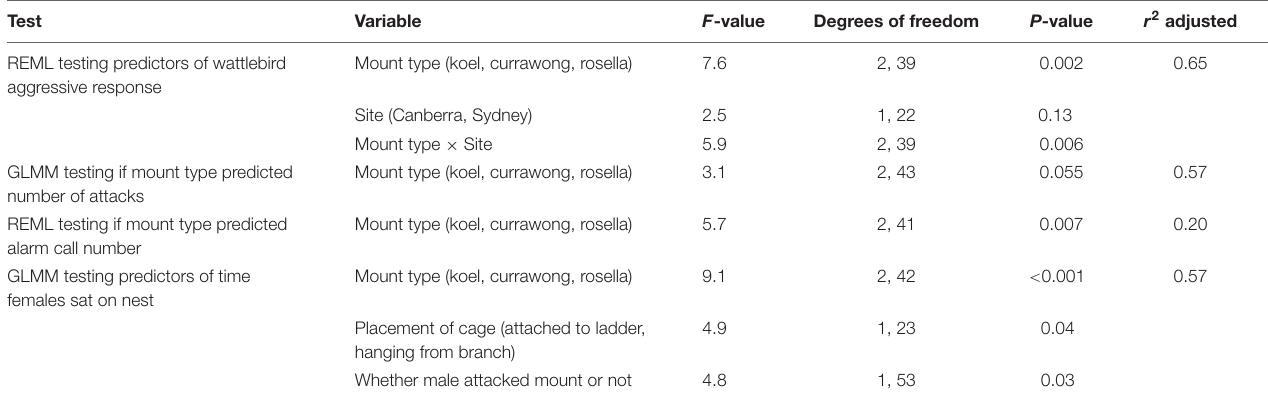
TABLE 2 | Results from the best REML testing what predicted wattlebird aggressive response, the GLMM testing if mount type predicted number of attacks, the REML testing if alarm call number was predicted by mount type, and the GLMM testing if females exhibited passive defense during mobbing experiments. Test Variable F -value Degrees of